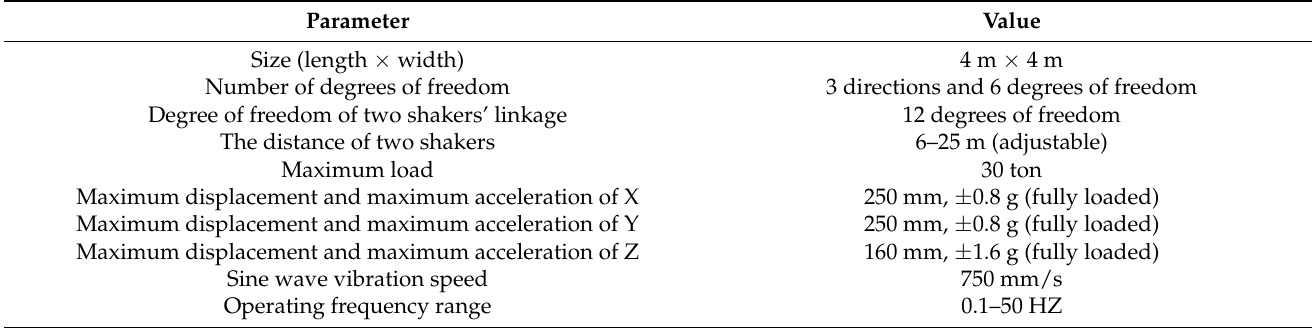
Table 3. Main technical parameters of shaking table of high-speed railway shaking-table test